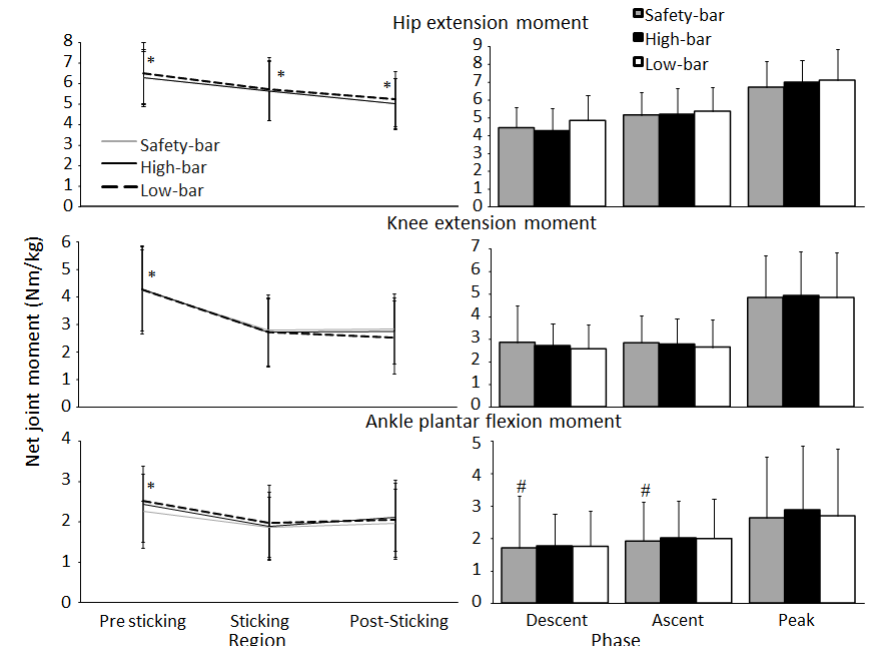
Figure 6. Mean ± SD net joint moments during descent, ascent, pre-sticking, sticking, post-sticking region together with peak net joint moments for the high-bar, low-bar, and safety-bar squat during 3-RM. * indicates a significant difference between this region and all other regions on a p ≤ 0.05 level for all squat conditions. # indicates a significant difference between this squat condition and the low-bar condition on a p ≤ 0.05 level.